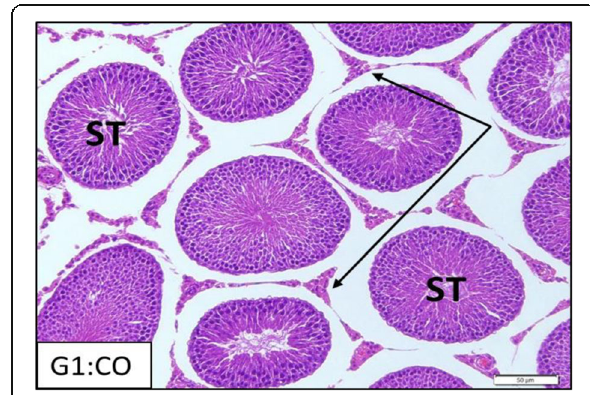
Fig. 5 Control group: sections from the rat testis stained showing seminiferous tubules (ST) interstitial Leydig cells were seen among the tubules (black arrows) (H-E, × 200)